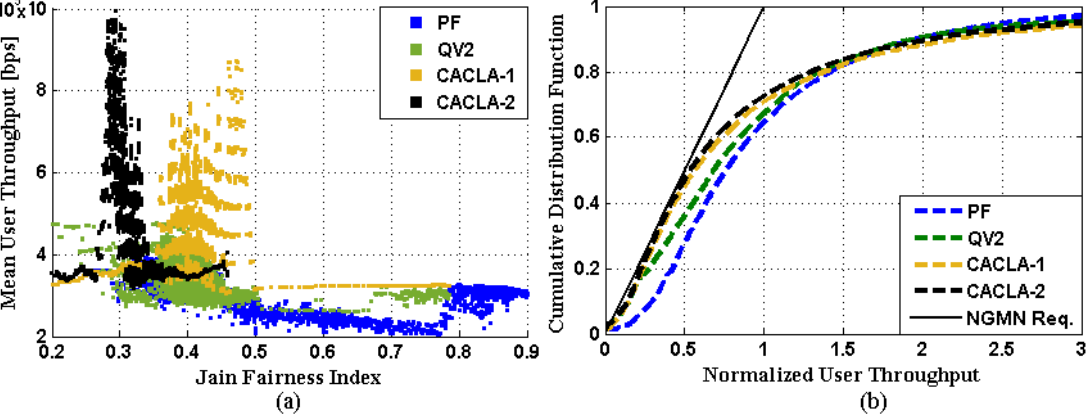
Figure 5. Fairness and throughput trade-off: ( a ) quantitative evaluation; ( b ) qualitative